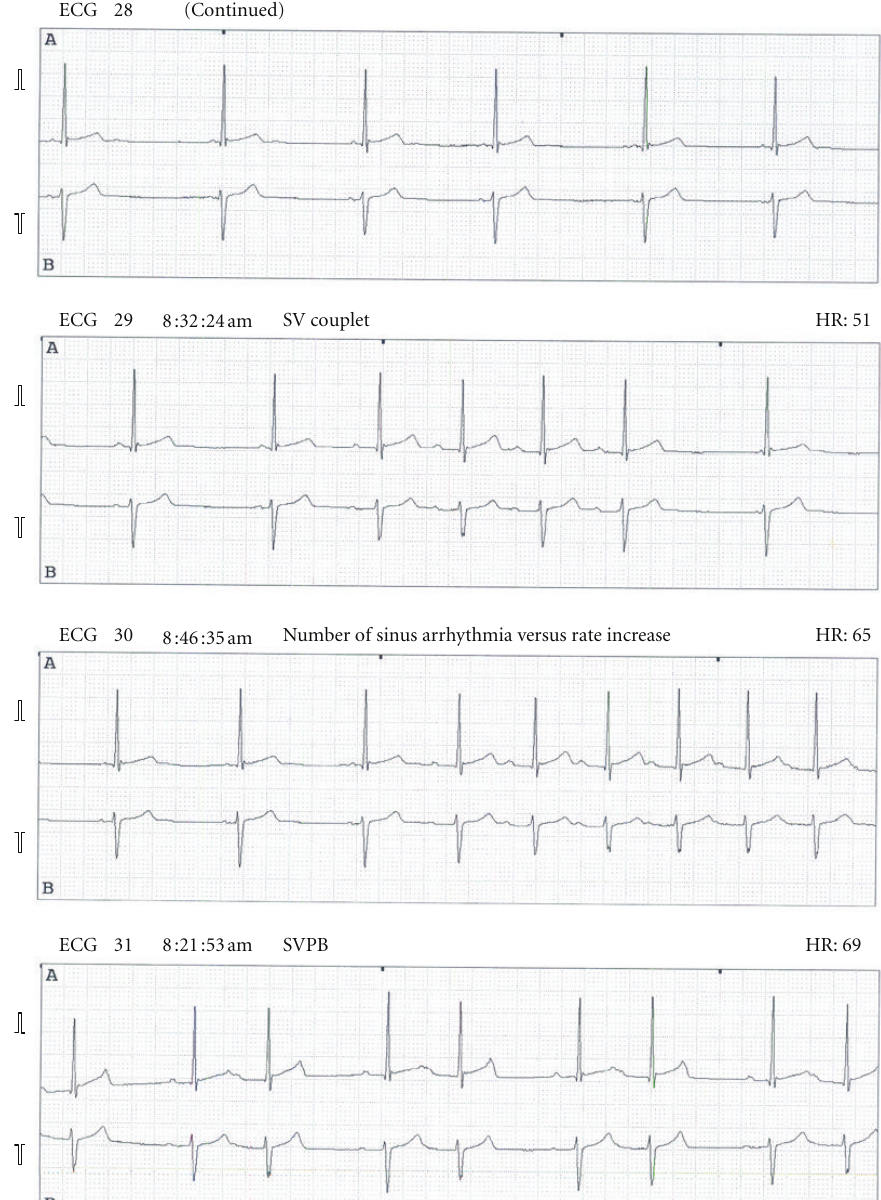
Figure 2: Holter monitor with